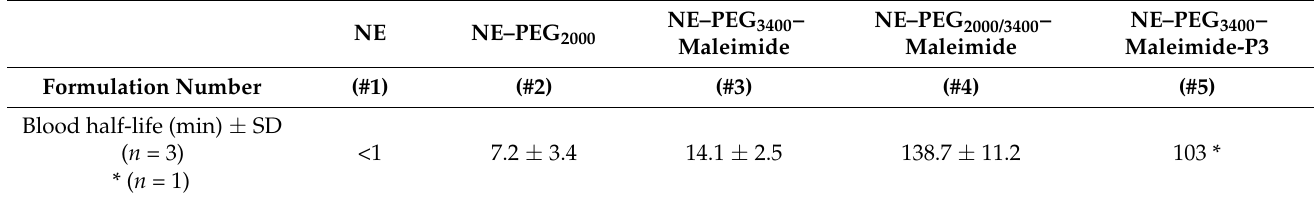
Figure 1. Estimation of the in vivo liver iron (Fe) uptake in mice by dynamic MRI after injection of the different NE formulations. Non-PEGylated NEs (#1) are rapidly cleared from the blood. NE-PEG 3400 -maleimide (#3) displays the best stealth properties with very low liver accumulation at 50 min. NEs decorated with PEG 2000 (#2) or PEG 2000 /PEG 3400 –maleimide (#4) displayed a similar profile, with a relatively rapid clearance. Each NE half-life was estimated from the corresponding graph (dashed lines in Figure 1; Table 2). Table 2. Half-life of the tested NE formulations in the